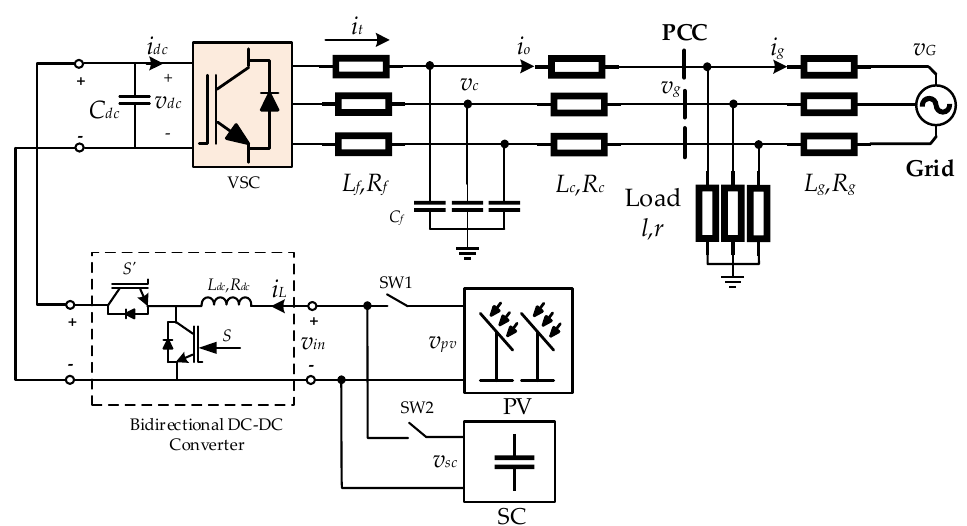
Figure 3. Proposed PV-supercapacitor energy storage system (power stage).